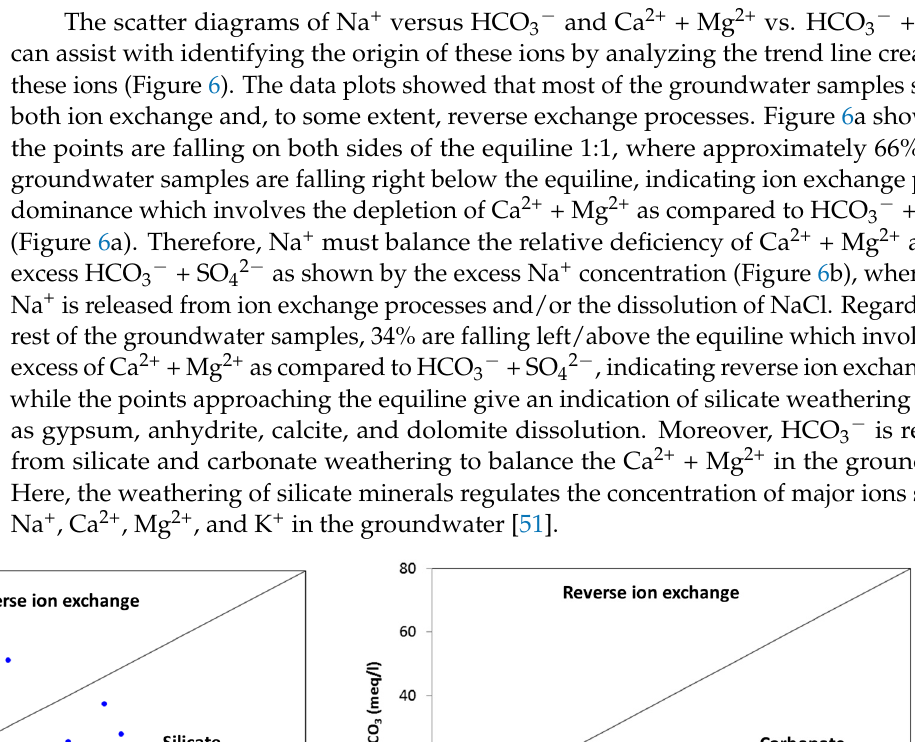
Figure 5. Gibbs Scatter diagram depicting the dominant mechanism controlling groundwater chemistry.